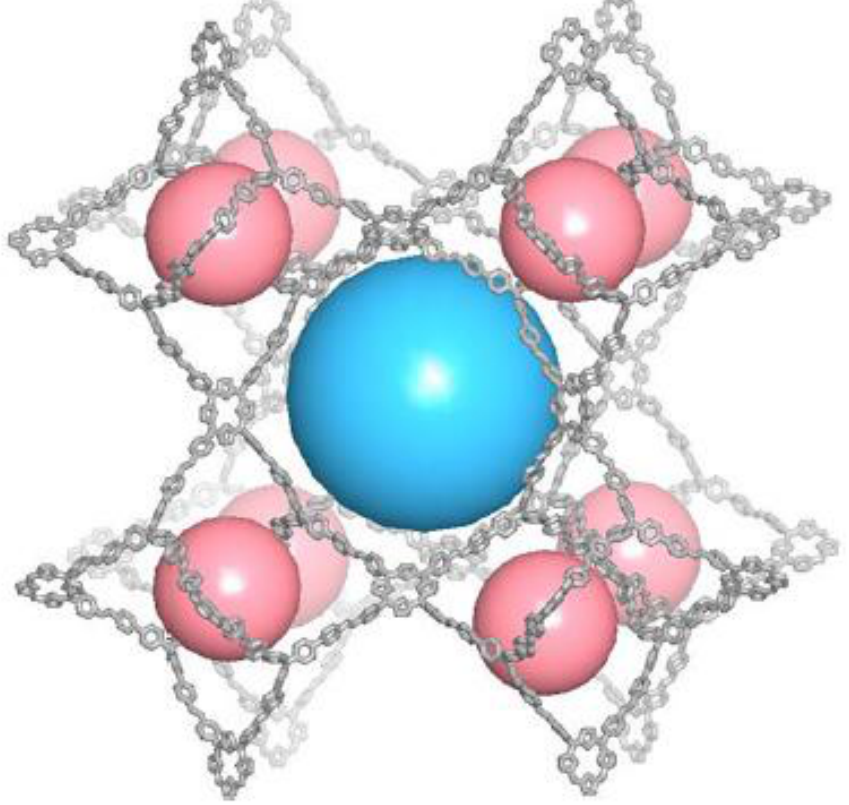
Figure 3. A 3D COF with tbo topology. Reprinted (adapted) with permission from [21]. Copyright {2020} American Chemical Society.